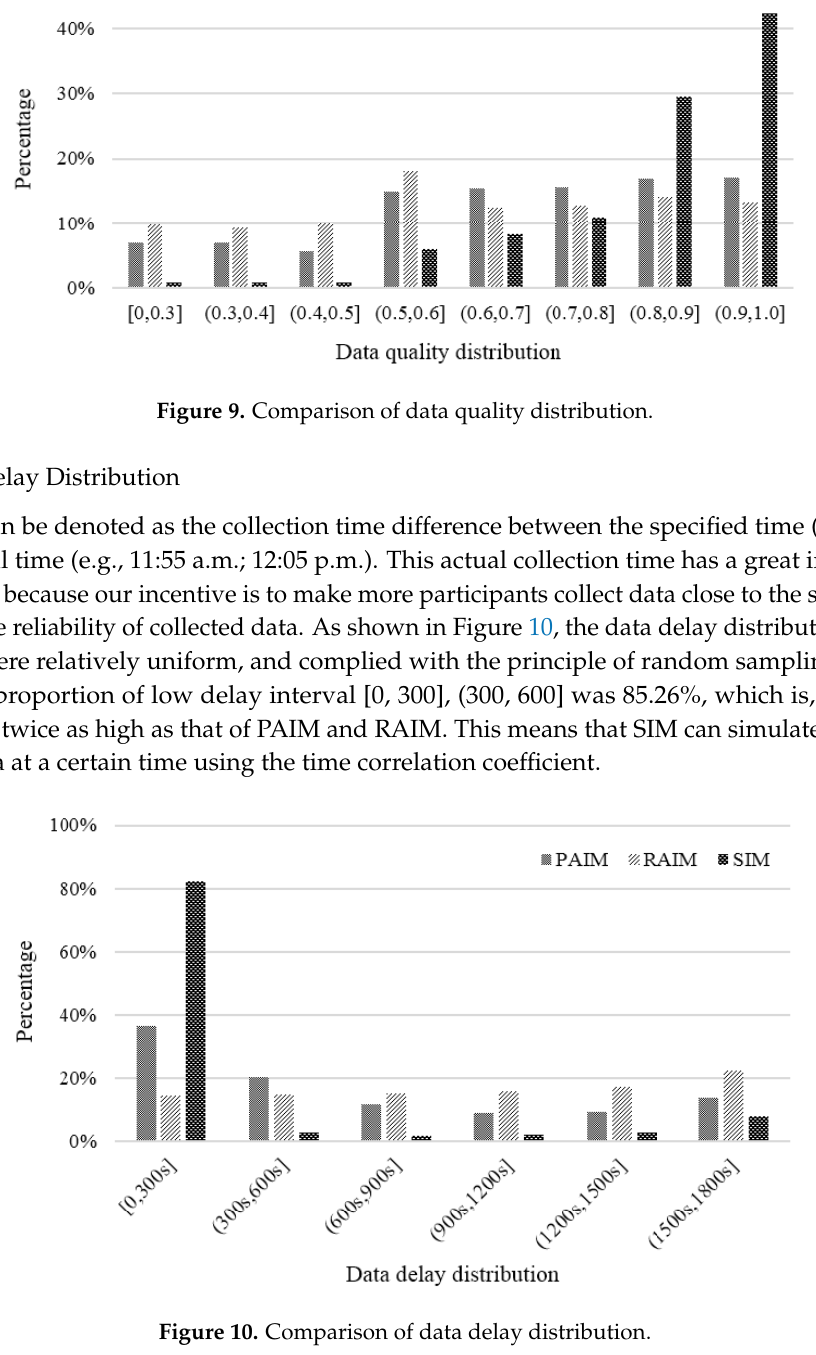
Figure 10. Comparison of data delay